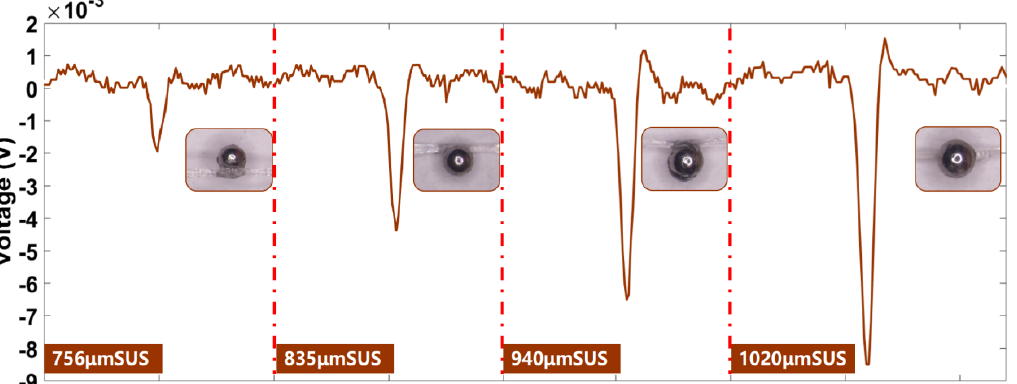
Figure 9. Inductive electric potential generated by 304 stainless steel particles of different particle sizes.